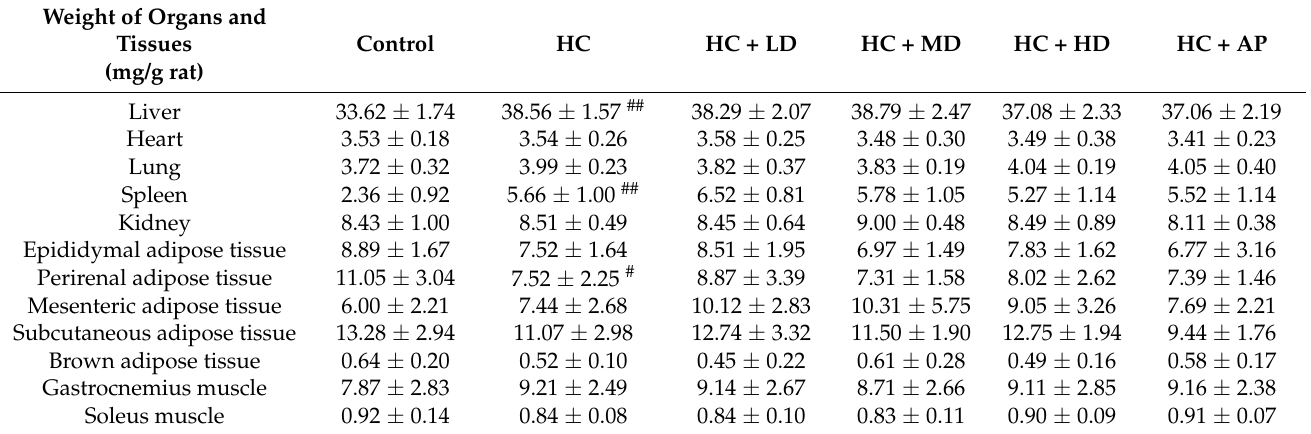
Table 2. Effects of TCI227 on the weights of organs, adipose tissues, and muscle tissues in PO-induced hyperuricemia SD rats.